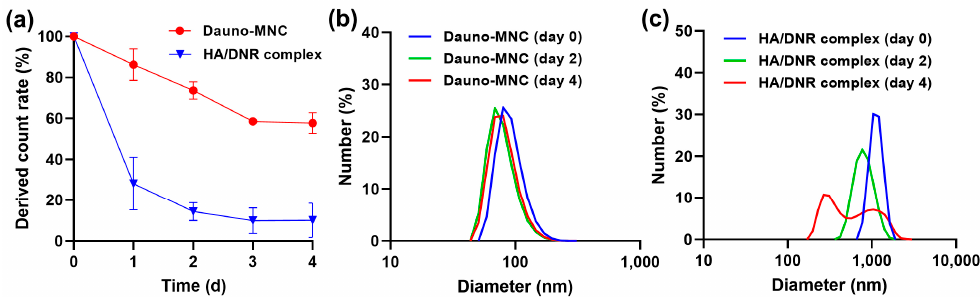
Figure 2. ( a ) Time-course change in derived count rate of Dauno-MNC and HA/DNR complex in PBS at 37 °C. Mean ± SD ( n = 3). ( b , c ) Size-distribution profiles of ( b ) Dauno-MNC and ( c ) HA/DNR complex in PBS measured over 4 days.